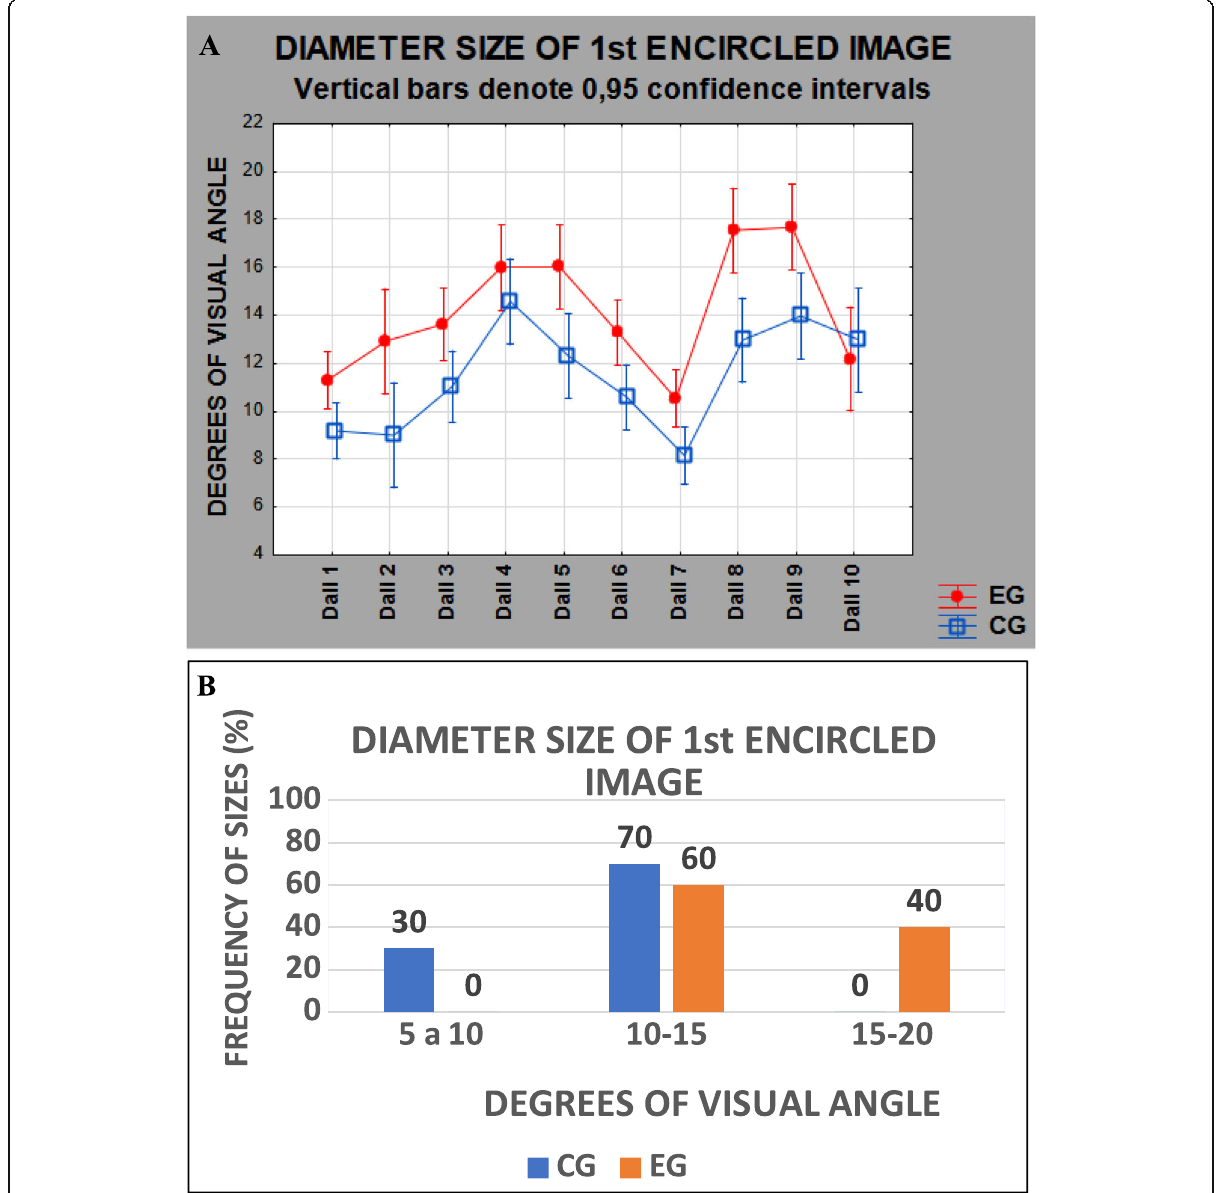
Fig. 3 Diameter size of 1st encircled image for Dalí ’ s paintings by group ( A ). The differences between groups were significant. Frequency of mean sizes, in degrees of visual angle, of the first images seen by volunteers in the 10 paintings of Dalí ( B ). Differences between groups